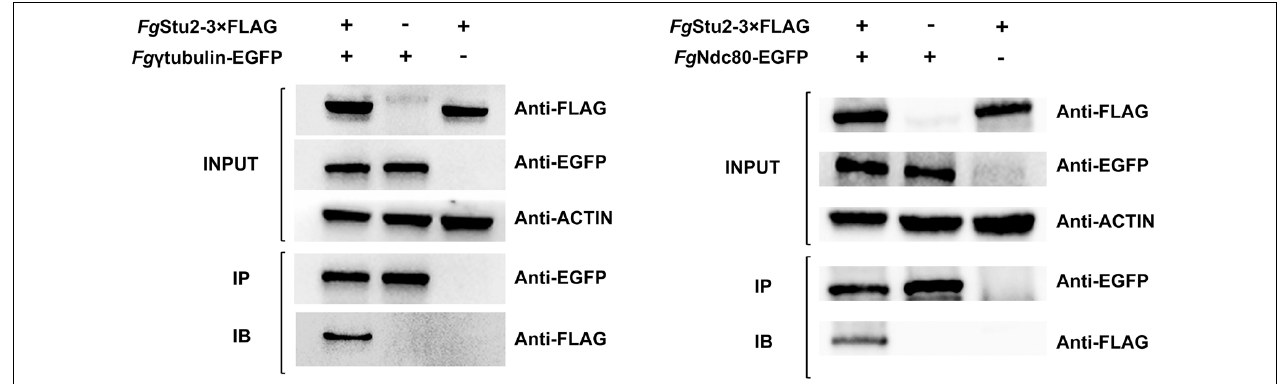
FIGURE 3 | Co-immunoprecipitation (Co-IP) analysis of interactions of Fg Stu2p- Fg γ -tubulin and Fg Stu2p- Fg Ndc80p. The INPUT (total protein) indicates that the double labeling strains ( Fg γ EGFP-Stu2-3 × FLAG and Fg Ndc80-EGFP-Stu2-3 × FLAG) and single labeling strains ( Fg Stu2-3 × FLAG, Fg γ -tubulin-EGFP, Fg Ndc80-EGFP) were successfully labeled with FLAG and EGFP tags respectively; the IP (Immunoprecipitation, polyclonal anti-EGFP rabbit antibody) indicates the Fg γ -tubulin-EGFP, Fg Ndc80-EGFP were precipitated by Protein-G magnetic beads which had been incubated with polyclonal anti-EGFP antibody; the IB (Immune blotting, monoclonal anti-FLAG mouse antibody) indicates that the Fg Stu2-3 × FLAG was pulled down by the Fg γ -tubulin-EGFP, Fg